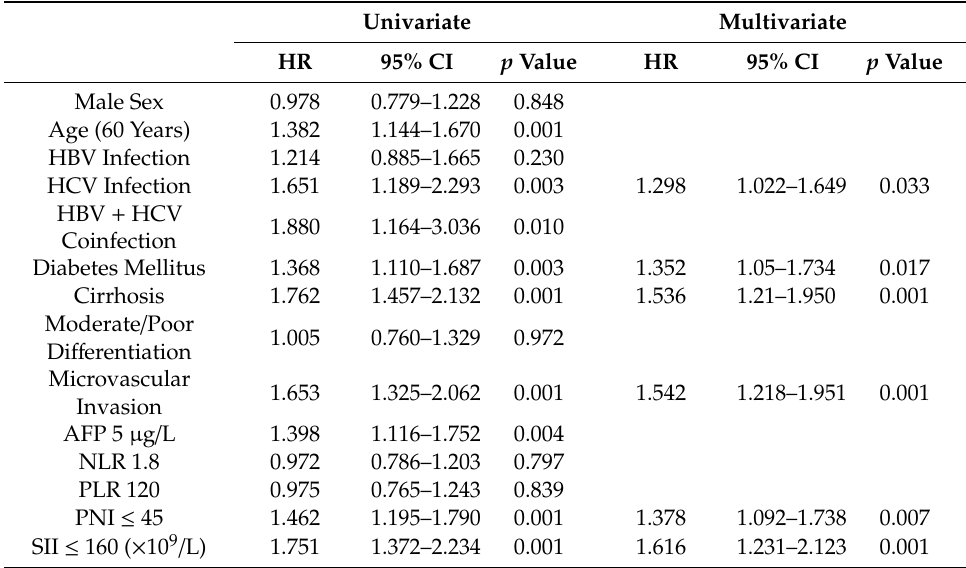
Table 5. Uni- and multivariate analyses of factors associated with recurrence by Cox proportional hazards model.